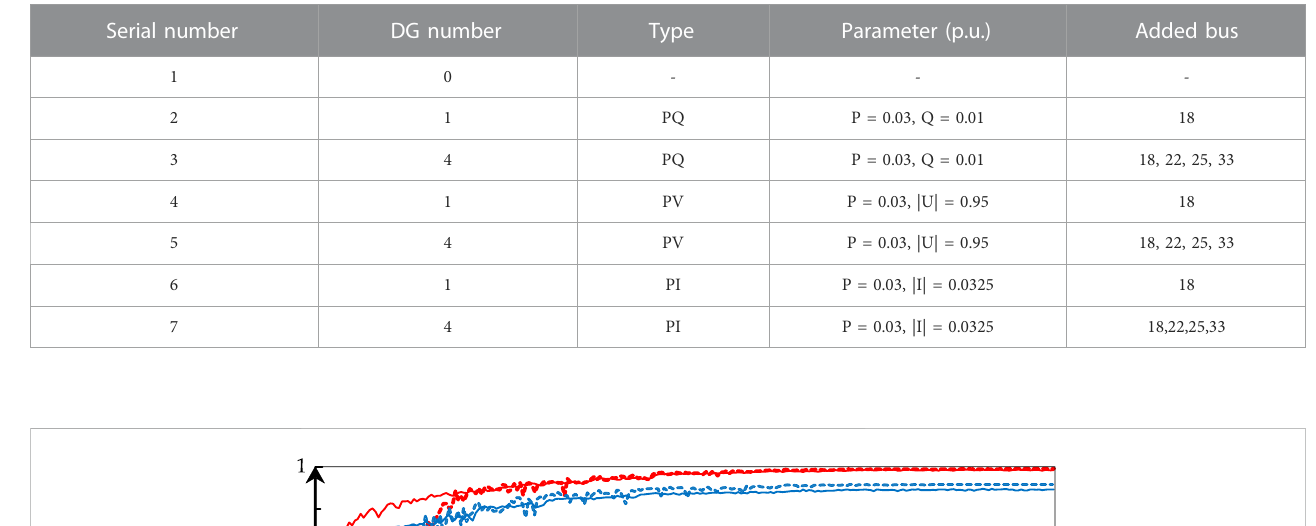
TABLE 3 DG con fi guration.